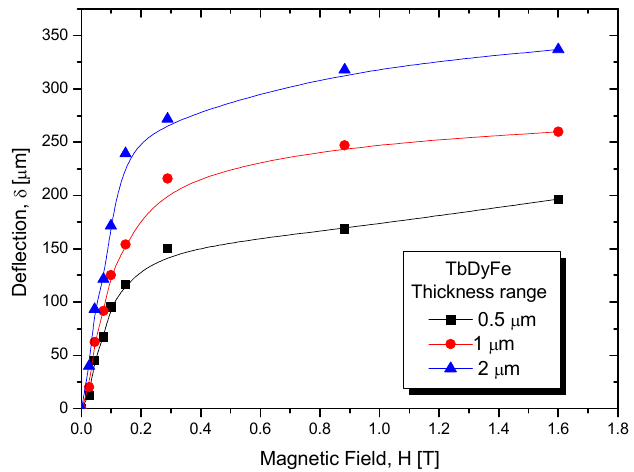
Figure 9. Magnetostriction and magneto-mechanical characteristics: Effects of the thicknesses of the TbDyFe film on the mirror